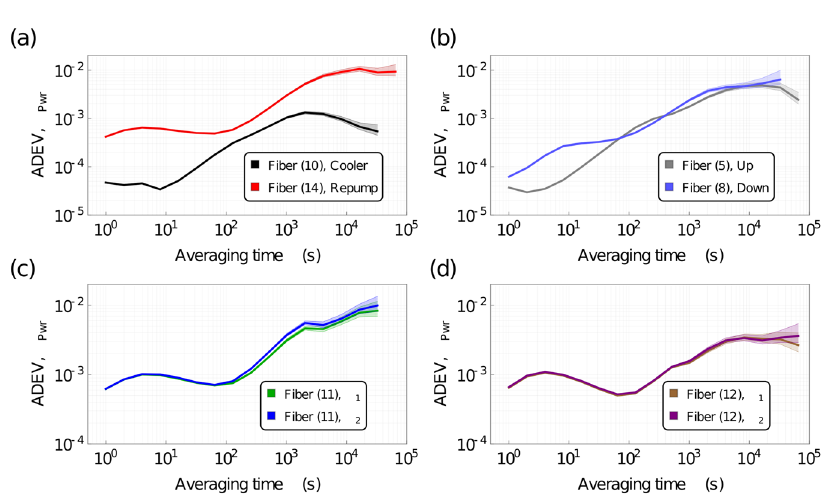
Figure 5. Overlapping Allan deviation of laser power stability (normalized to output power). ( a ) Detection frequencies. Different total beam paths through the micro-optic modules lead to different power drifts. ( b ) 3D MOT “Up” versus “Down” balance. The beam paths are similar, which leads to similar low frequency drift. ( c ) Power stability of both Raman frequencies in fiber (11). ( d ) Power stability of both Raman frequencies in fiber (12). The shaded regions show the minimum and maximum